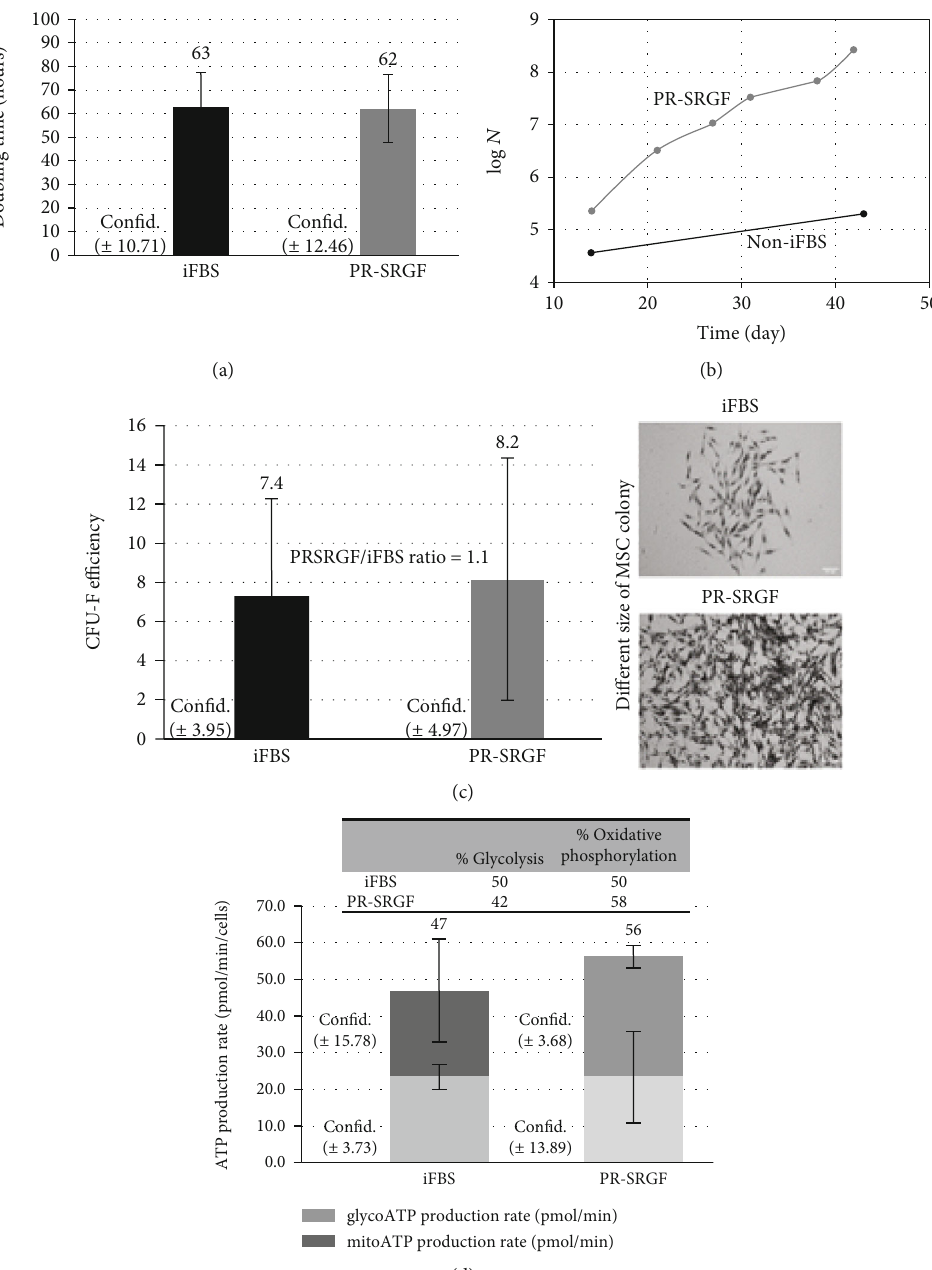
Figure 1: In fl uence of di ff erent media supplements on MSC behaviour. Analyses of MSCs cultivated in media with heat-inactivated FBS (iFBS) and platelet releasate (PR-SRGF): (a) doubling time of MSC during fi rst 48h of cultivation; (b) long-term proliferation of MSCs during 42 days of cultivation; (c) CFU-F and colony morphology during fi rst 48 h of cultivation (white bars correspond to 232 μ m); (d) ATP production rate (pmol/min/cells) and % of glycolysis and oxidative phosphorylation after 24h of cultivation ((a – d)+ (f) in 10% iFBS and 7.5% PR-SRGF; (e) in 10% non-iFBS and 7.5% PR-SRGF). Statistical analysis was done by one factor ANOVA ( p < 0 : 05 ) with post hoc Fischer LSD test (95% con fi dence interval was determined to verify the similarity/comparability of samples with a nonsigni fi cant di ff